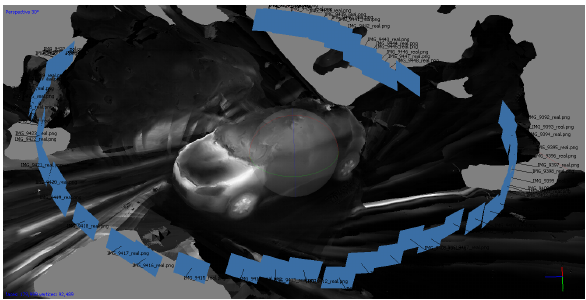
Figure 8. The resulting 3D model with the infrared